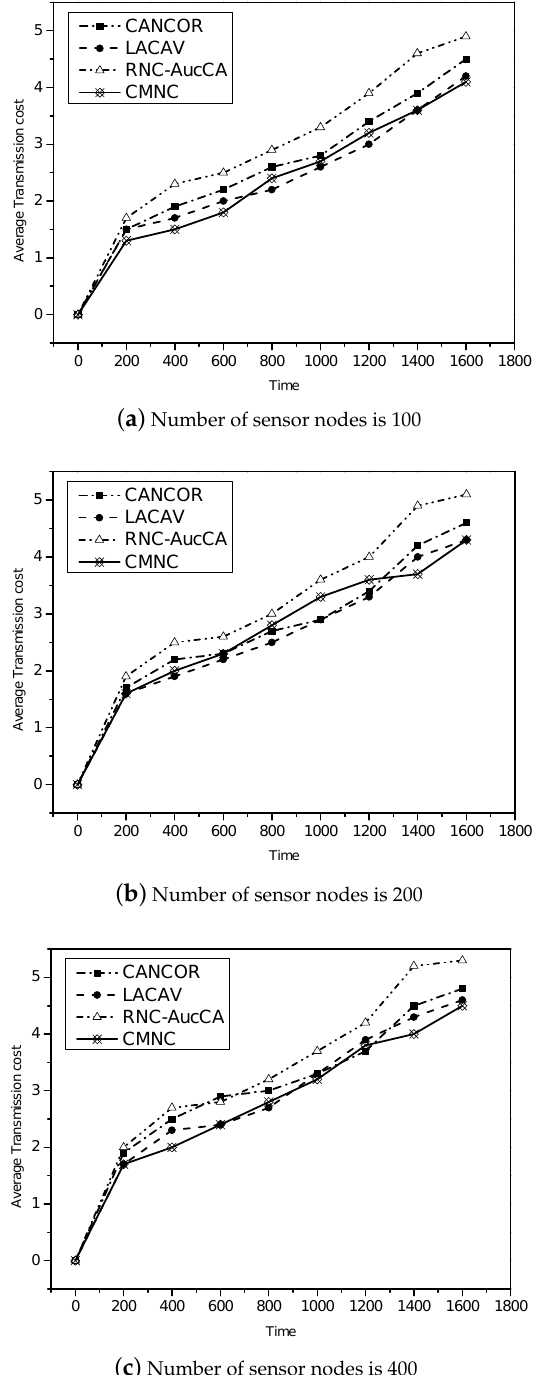
Figure 7. The relationship between the average transmission cost and the number of sensor